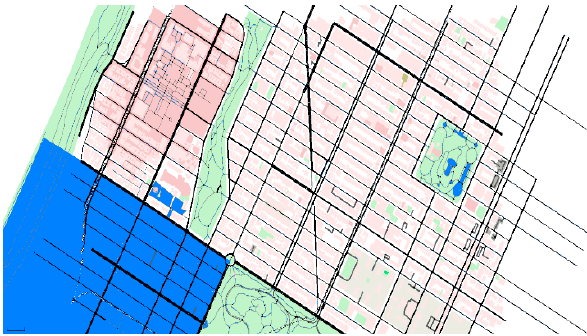
Figure 5. Simulation Scenario of Manhattan City Map.